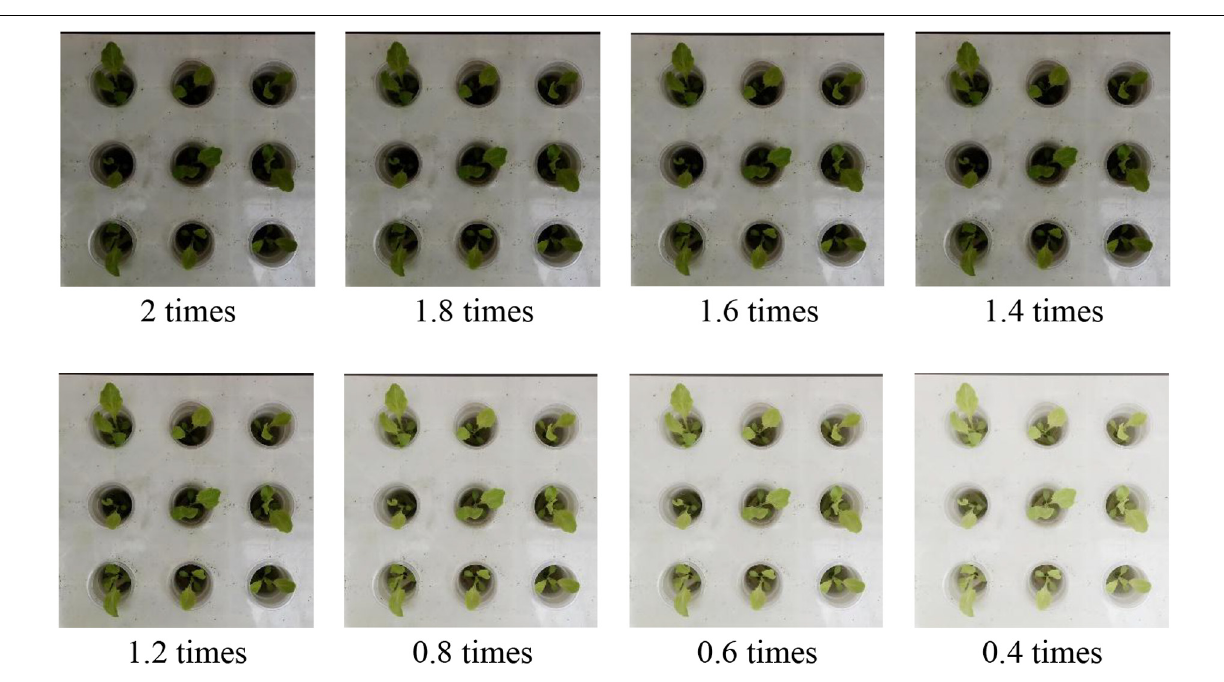
FIGURE 4 | Data enhancement based on contrast adjustment. The adjustment of the image contrast is realized by the gamma adjustment method. When gamma > 1, the new image is darker than the original image. If gamma < 1, the new image is brighter than the original